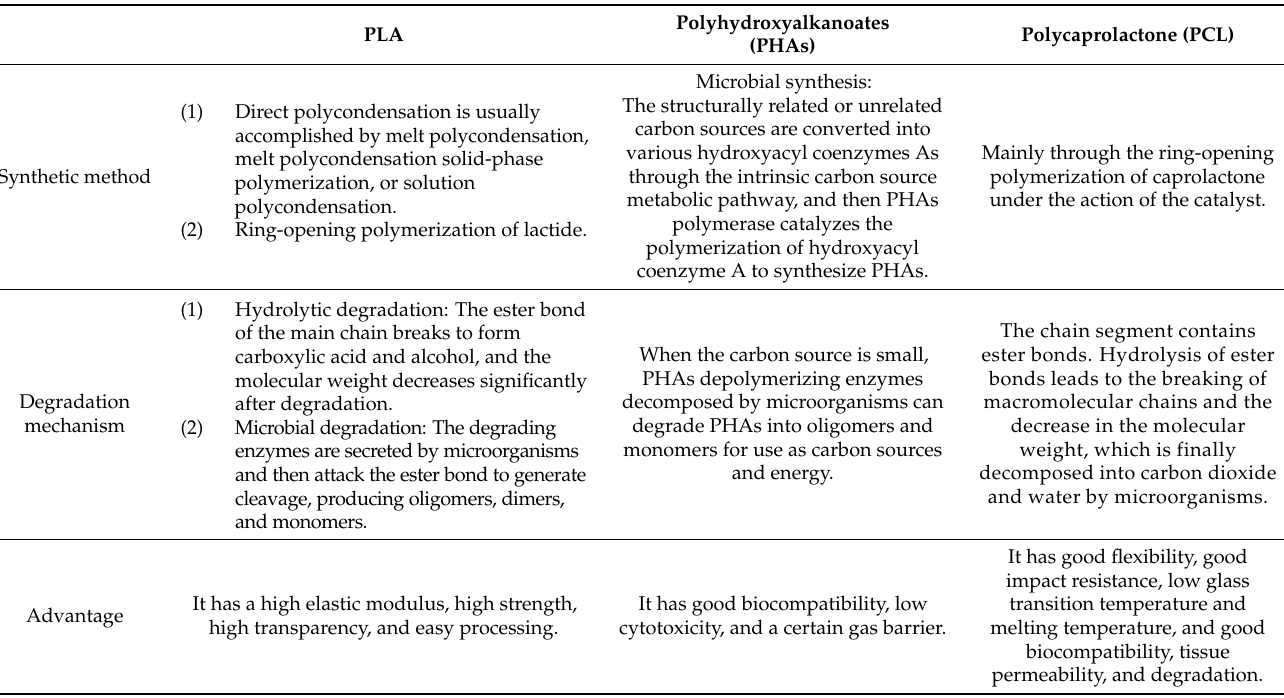
Table 1. Synthesis method, degradation mechanism, characteristics, and application of